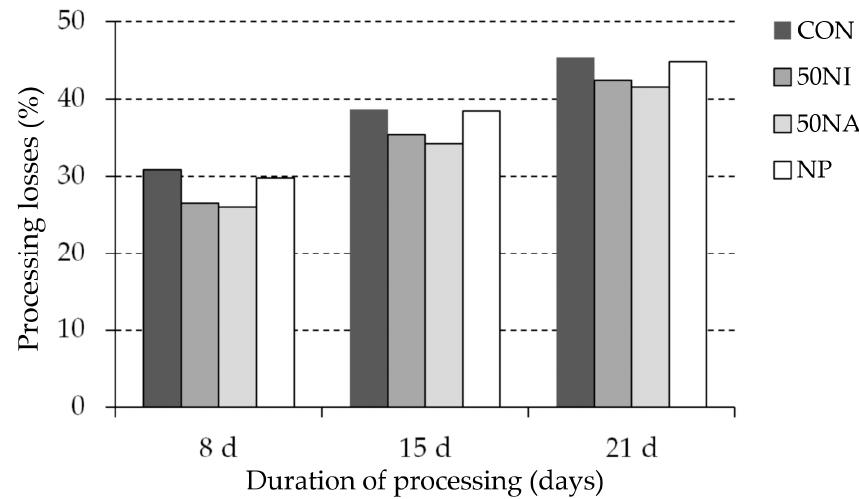
Figure 3. Processing loss (in %) according to formulation (CON = control with 110 mg/kg sodium nitrite and 0.2% phosphates; 50NI = 50% less sodium nitrite than in control; 50NA = 50% less sodium nitrite than in control with added 225 mg/kg sodium ascorbate; NP = no phosphates and 110 mg/kg sodium nitrite). Table 1. Evaluation of mold covering of the sausage surface (visual assessment on a scale 1–5) . CON 50NI - CON a 50NA - CON a NP - CON a RMSE